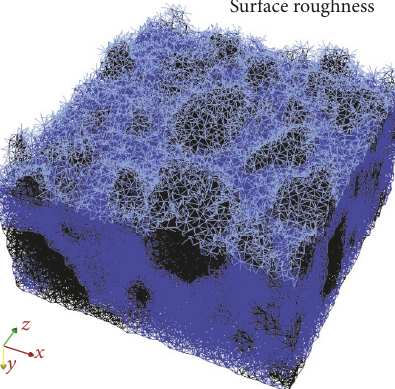
Figure 7: Simulated rough substrate material structure, showing coarse aggregates (black) and mortar (blue).